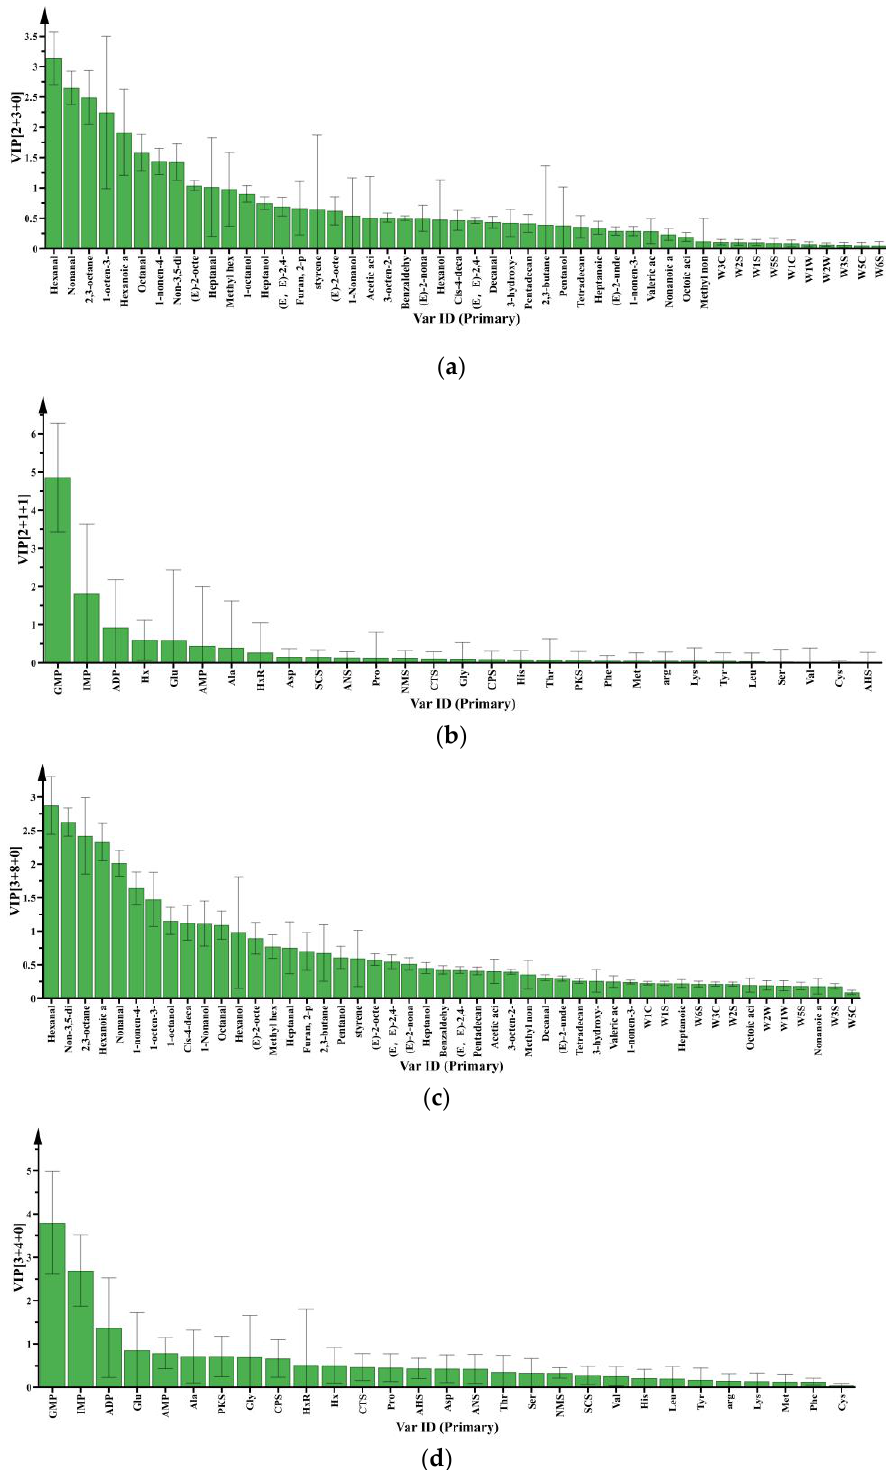
Figure 4. VIP values of volatile compounds and non-volatile compounds in raw meat at different chilling rates and different refrigeration times. ( a ) VIP values of volatile compounds at different chilling rates. ( b ) VIP values of non-volatile compounds at different chilling rates. ( c ) VIP values of volatile compounds at different refrigeration times. ( d ) VIP values of non-volatile compounds at different refrigeration times.